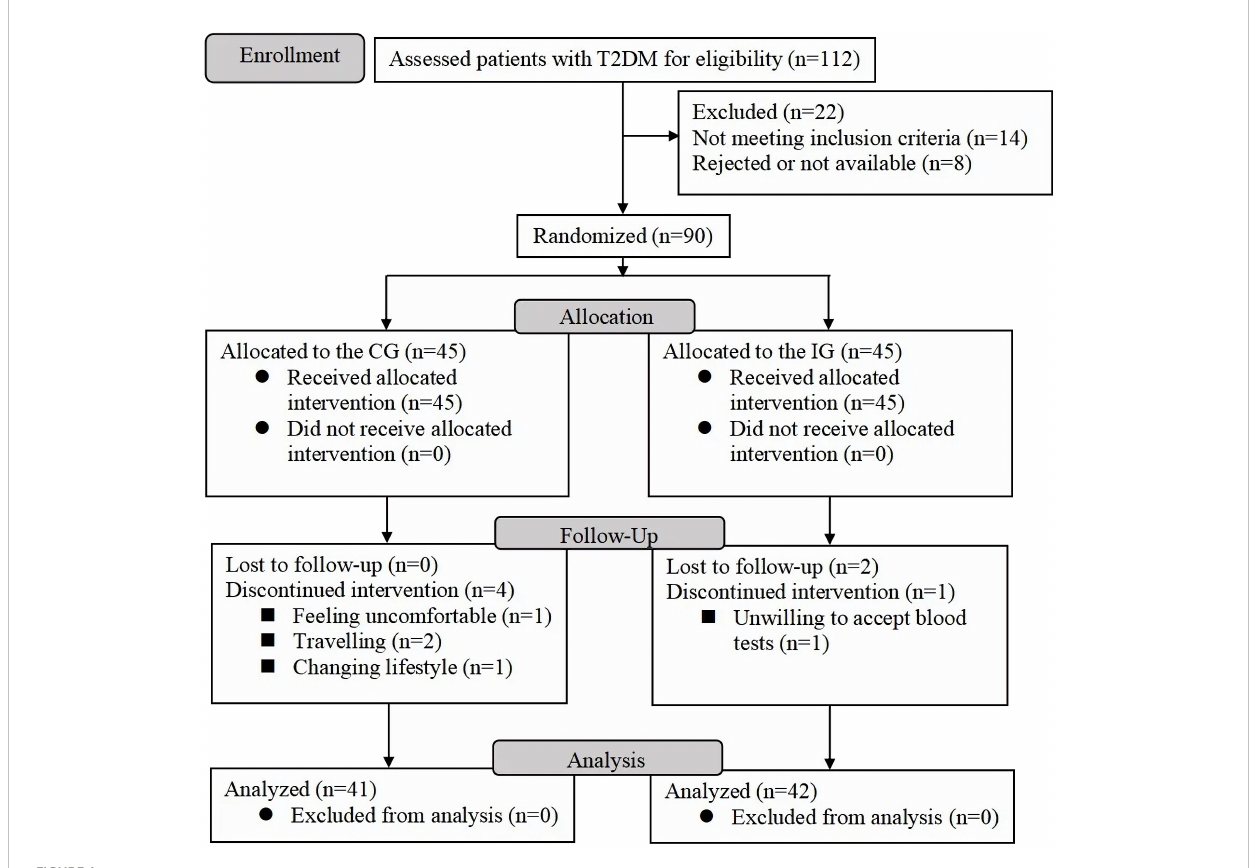
FIGURE 1 Participant fl owchart. CG, control group; IG, intervention